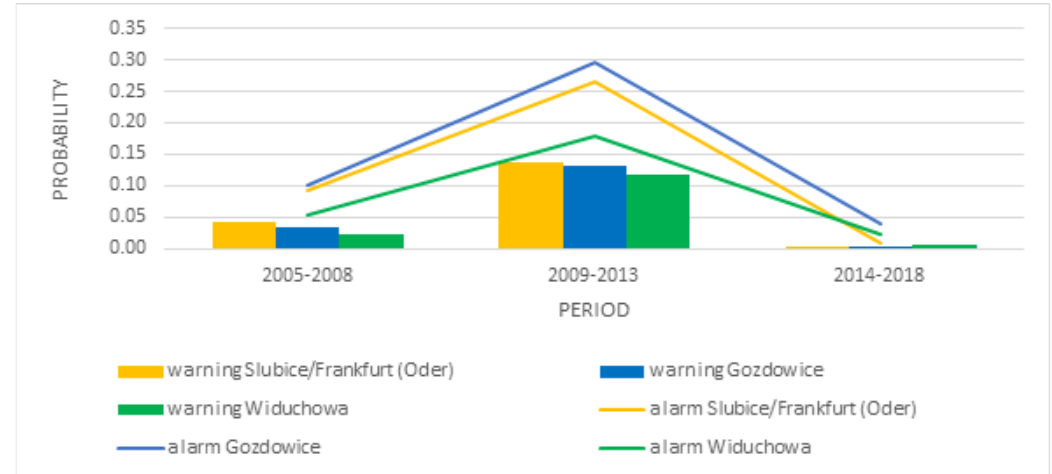
Figure 4. Graph of probabilistic measures of rainfall risk in the studied locations between 2004 and 2018. Source: Own